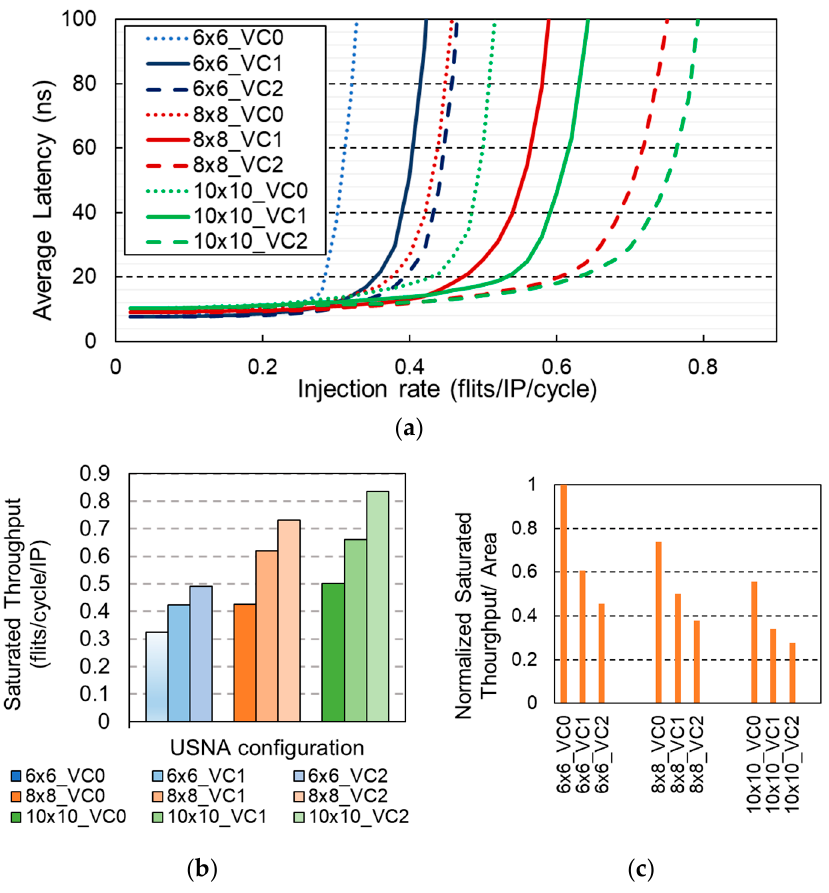
Figure 7. Performance comparison of various USNA configurations: ( a ) average latencies, ( b ) saturated throughputs, and ( c ) normalized saturated throughput/area.